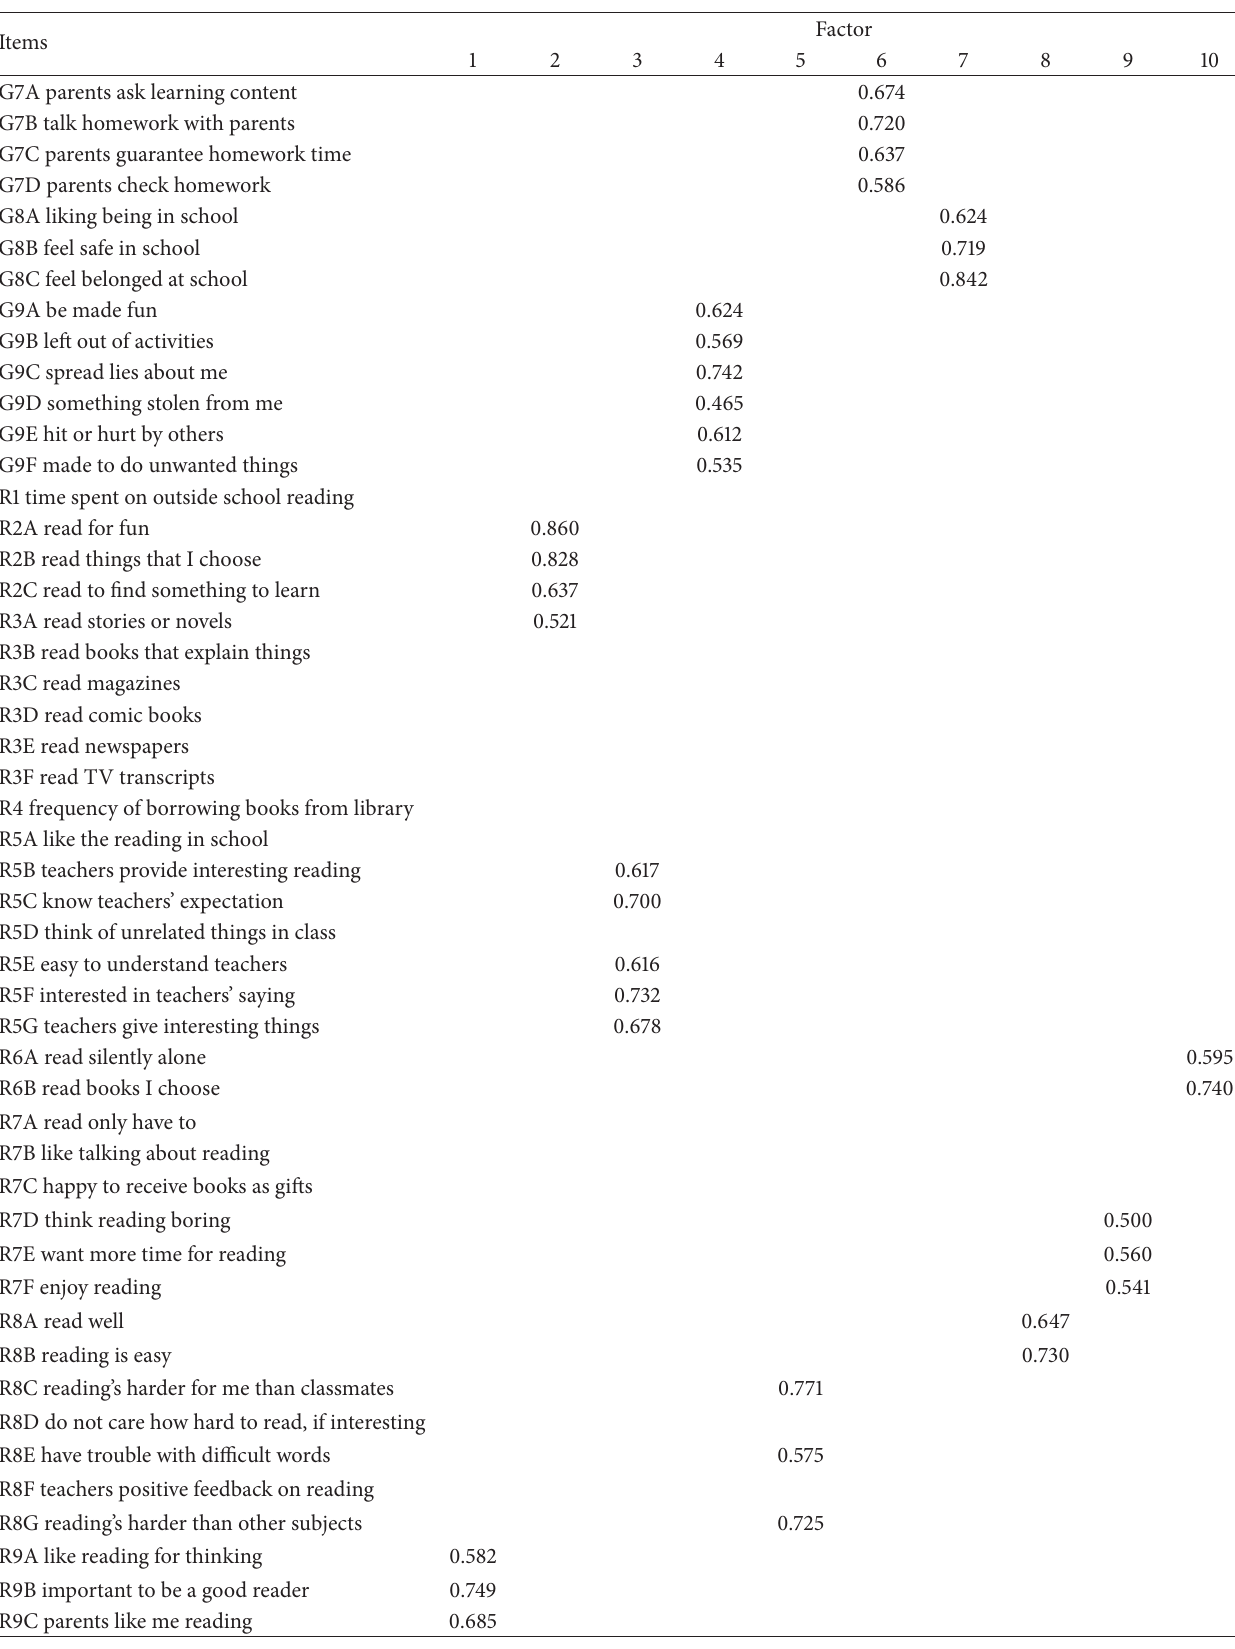
Table 2: Exploratory factor analysis for the PIRLS 2011 student questionnaire (PIRLS-SQCV